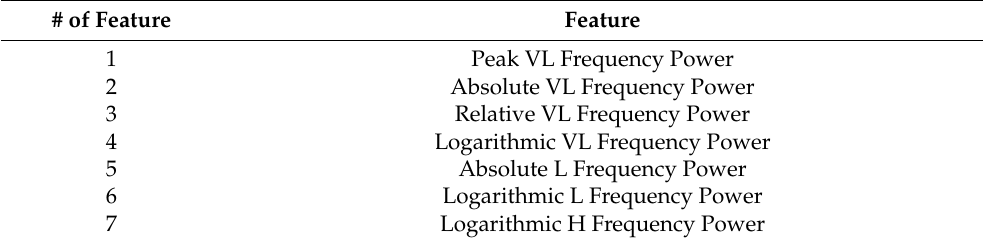
Table 7. Significant features regarding frequency-domain using the Welch method.